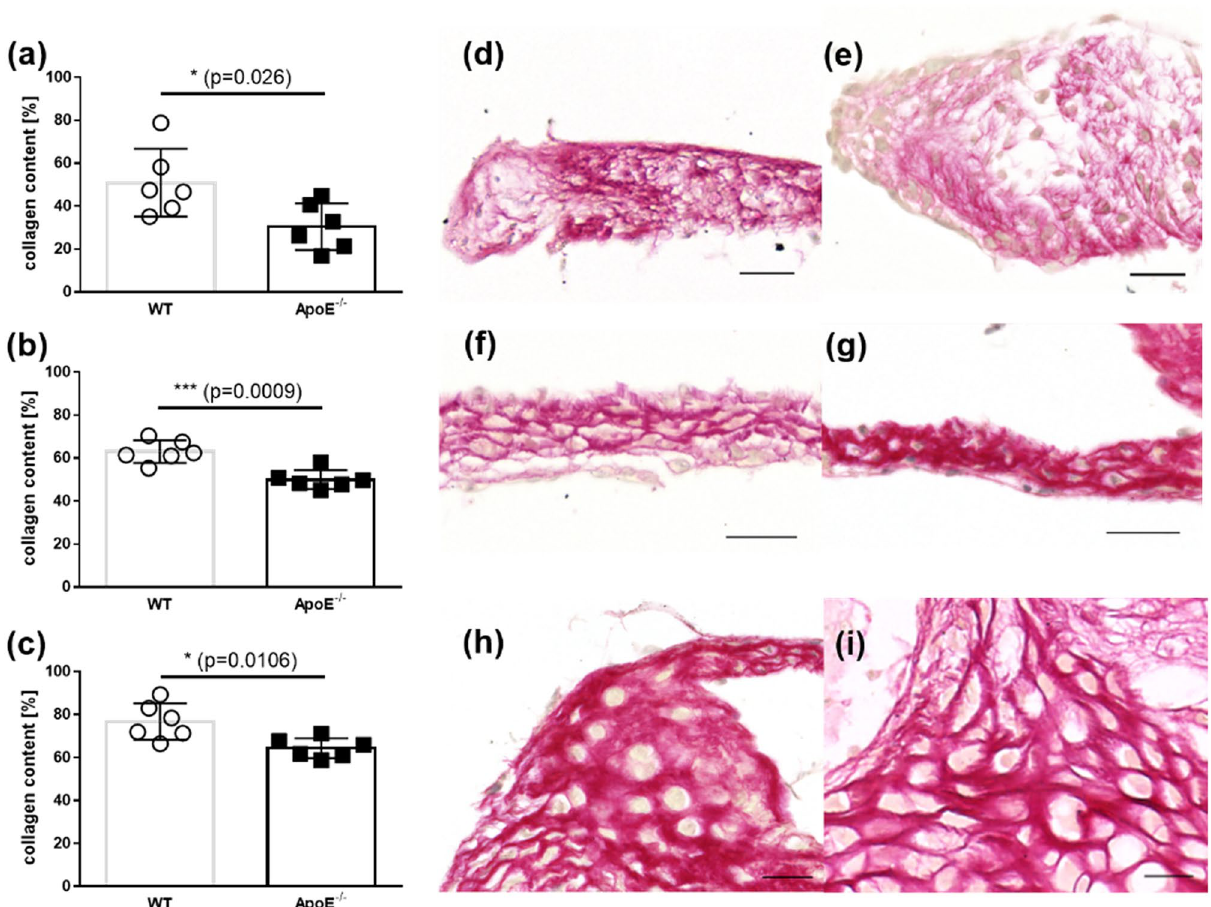
Figure 4. Quantitative analysis of picrosirius red-stained slides of aortic valve leaflets. The mean collagen content from ( a ) the region1, ( b ) the region 2, and ( c ) the region 3 from WT and ApoE −/− mice ( n = 6). Representative picrosirius red-stained slides of the region 1 from ( d ) WT mice and ( e ) ApoE −/− mice, of the region 2 from ( f ) WT mice and ( g ) ApoE −/− mice, and of the region 3 of ( h ) WT and ( i ) ApoE −/− mice. The scale bar is 20